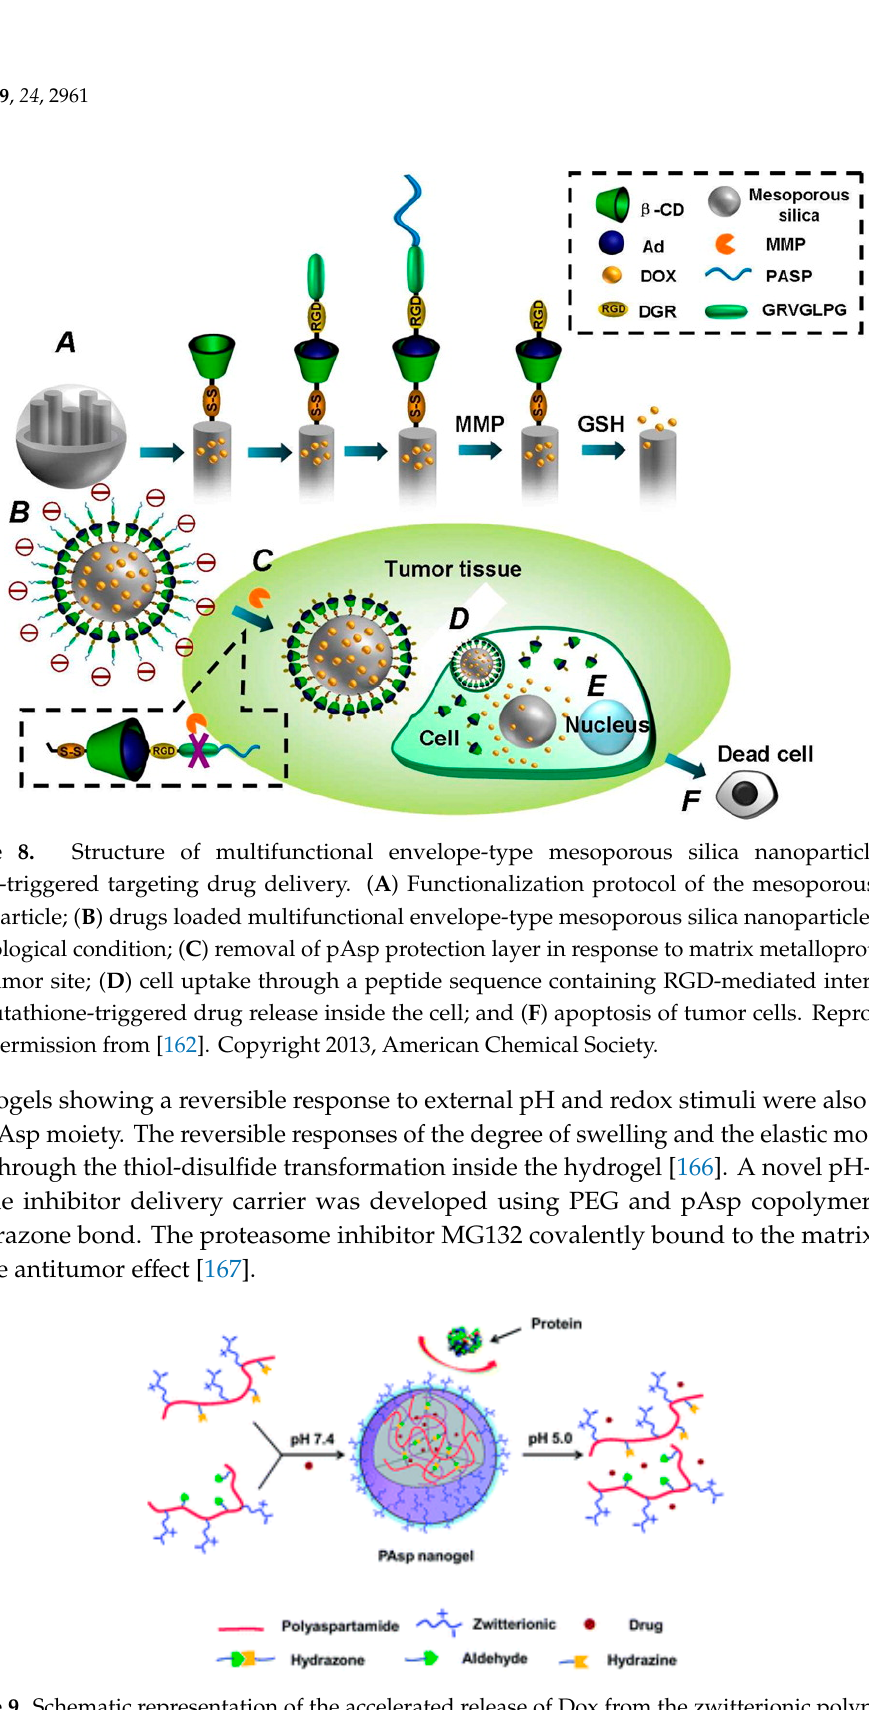
Figure 9. Schematic representation of the accelerated release of Dox from the zwitterionic polypeptide in acidic pH and its anti-adsorption against protein. Reproduced with permission from [168]. Copyright 2014, Royal Society of Chemistry.